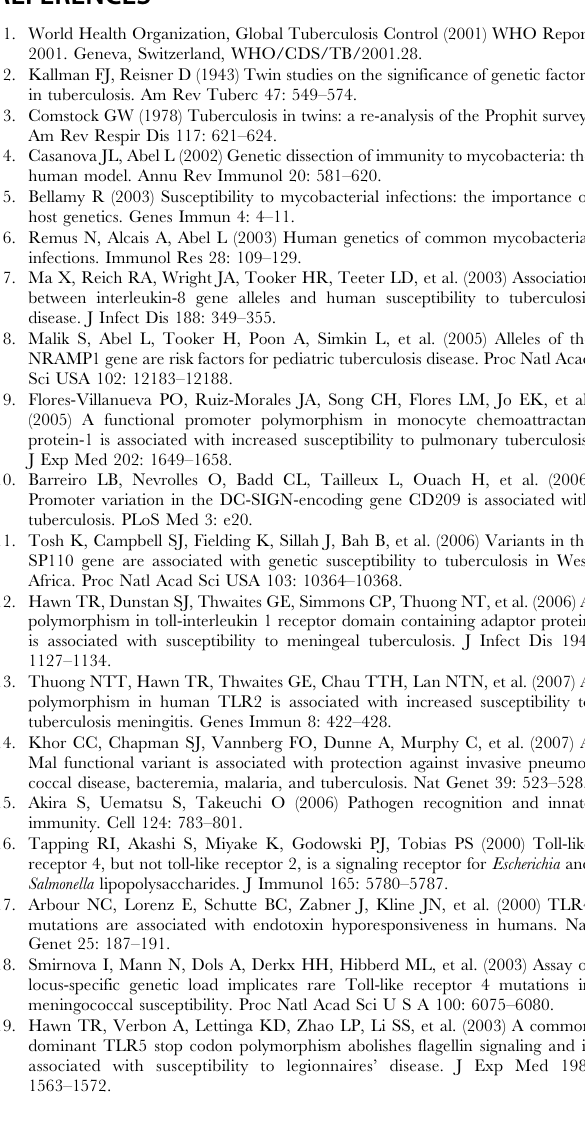
Table S3 Haplotype analysis of TLR6 genetic variants